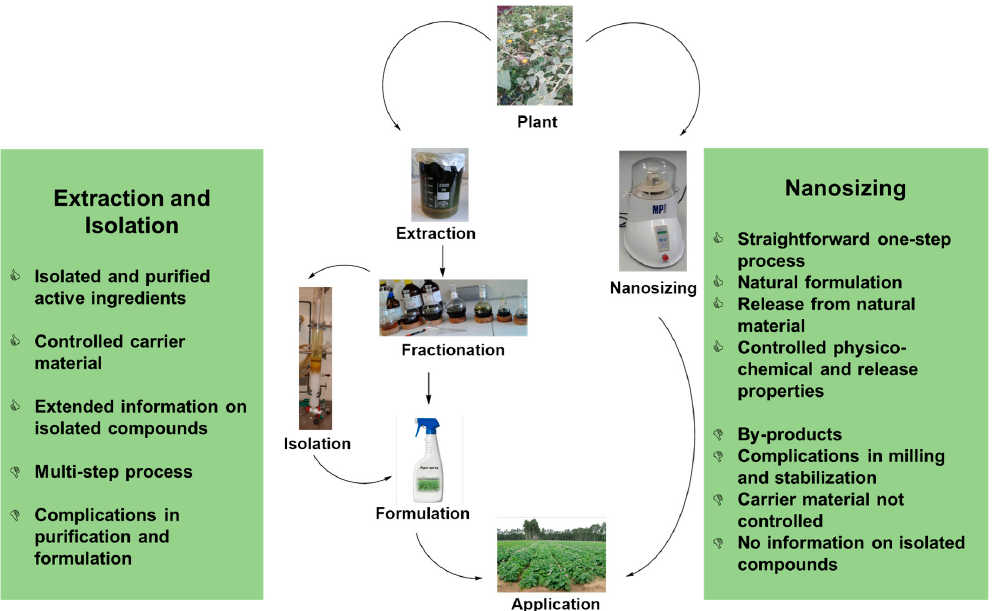
Figure 7. Schematic comparison of the more conventional methods to unlock the biological potential of natural materials via extraction, isolation, refinement and formulation on the left versus nanosizing of the crude material on the right (nanosizing may contain several steps, yet the methods are closely related). The major benefits and draw-backs associated with both avenues—as far as we are currently aware of—are highlighted. There are also various critical questions raised by nanosizing which ultimately deserve our